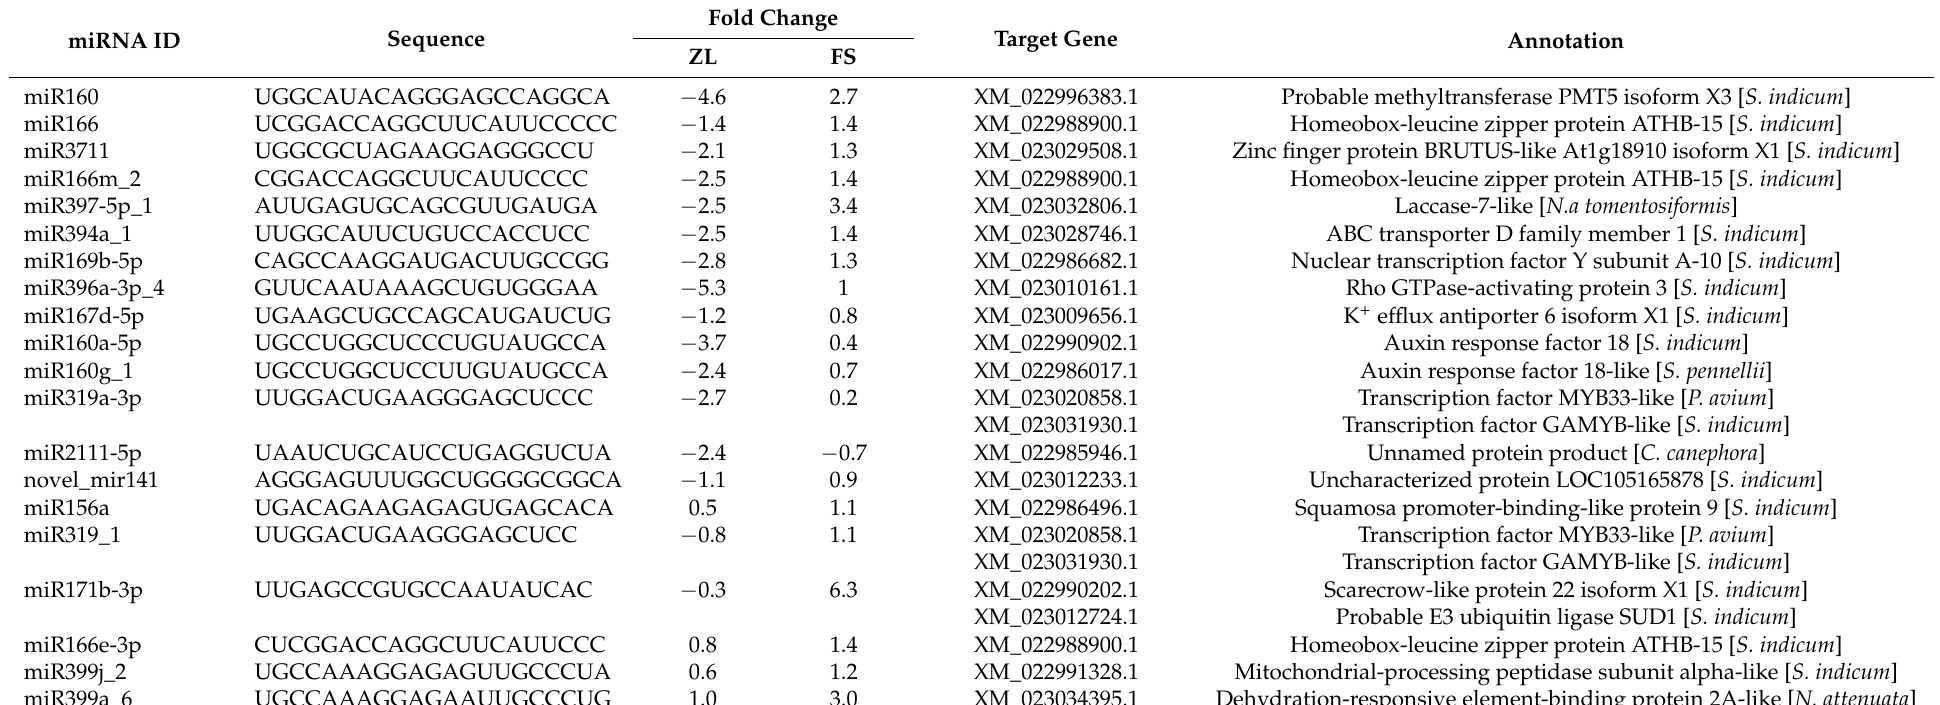
Table 1. MicroRNAs associated with Al-tolerance in two contrasting olive